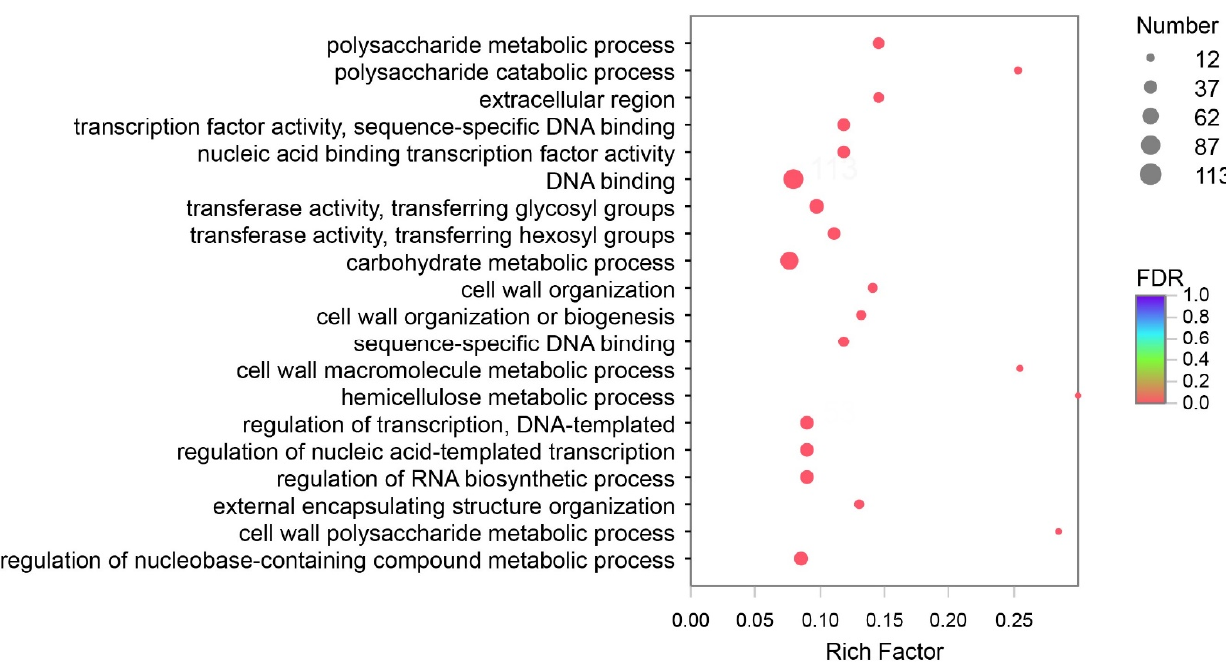
Figure 5. Gene Ontology (GO) enrichment analysis with the differentially expressed genes (DEGs). A total of 1104 DEGs were categorized in three main GO classification categories.